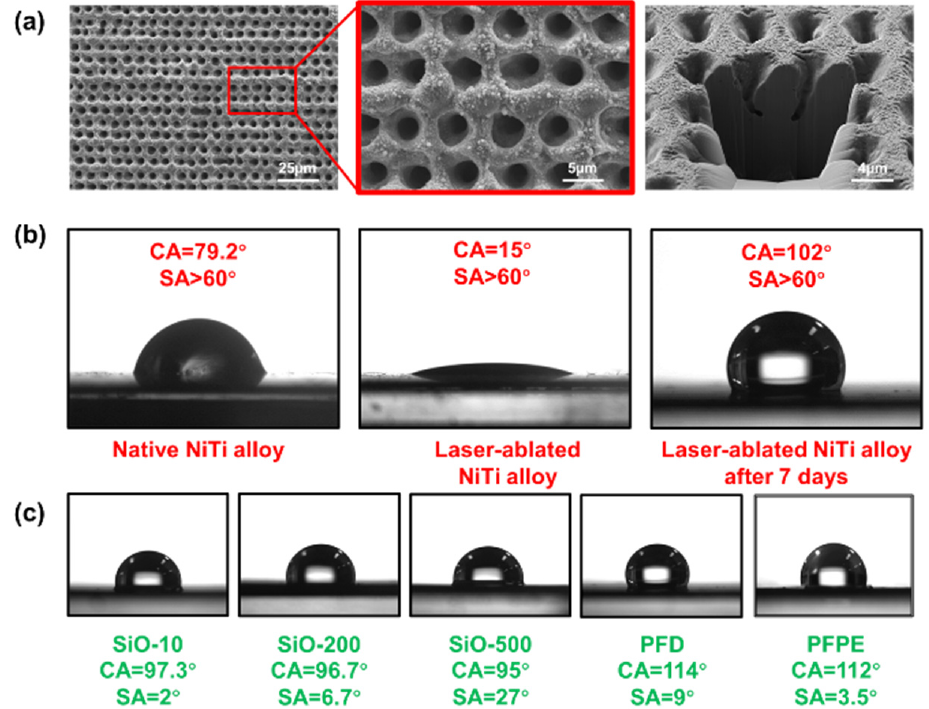
Figure 2. Microstructure of the NiTi alloy surface and its water-repellent properties: ( a ) Top view and cross-sectional view of the structure taken by scanning electron microscope. ( b ) Wettability of the native NiTi alloy samples after laser ablation and after being placed in air for 7 days. ( c ) Wettability of the SLIPSs prepared using SiO-10, SiO-200, SiO-500, PFD, and